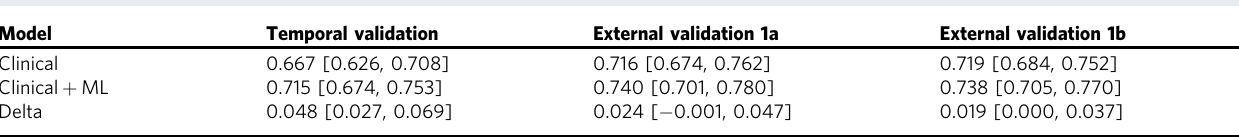
AUROCs for LNM predictions for logistic regressions with various feature sets. Clinical baseline clinicopathologic variables (age, sex, tumor grade, T-category, lymphatic invasion, venous invasion). Clinical + ML baseline clinicopathologic variables plus 5 machine-learned features. Delta the difference between Clinical + AI and Clinical. 95% con fi dence intervals computed via